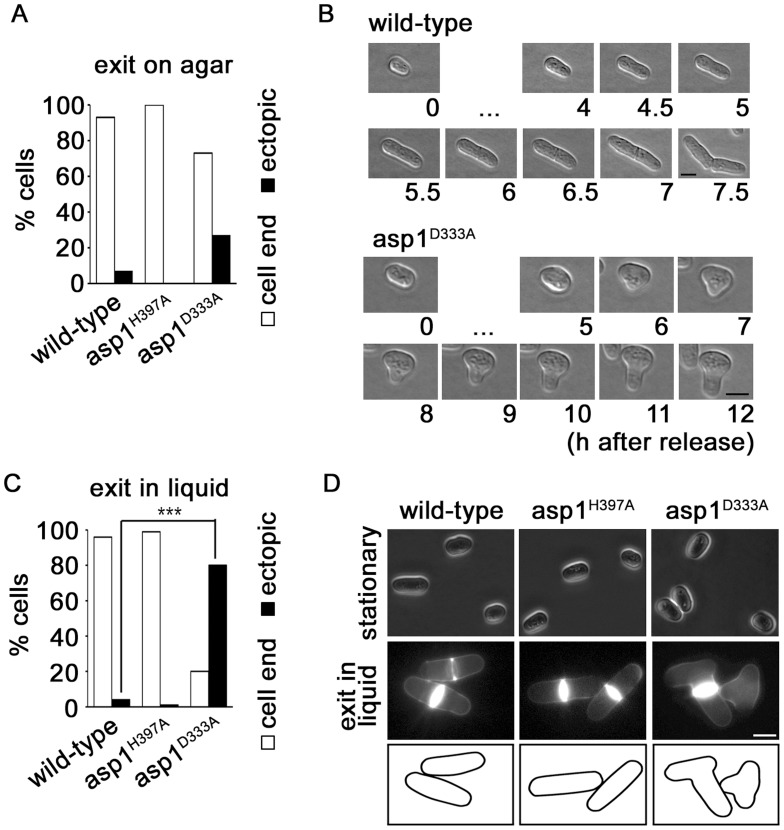
Asp1 is required for growth zone selection.(A) The indicated strains were released from stationary phase by streaking cells on solid YE5S at 25°C and analyzing the cell shape microscopically. Wild-type strain, n = 16; asp1H397A, n = 19; asp1D333A strain, n = 15. (B) Photomicrograph of a wild-type and asp1D333A cell that exits stationary phase on solid agar. Bars, 5 µm. […] denotes no change in cell morphology at these time points. (C) The indicated strains were released from stationary phase by inoculating an aliquot with YE5S liquid medium. Phenotype was scored after 7 hrs at 25°C. Wild-type strain, n = 142; asp1H397A, n = 110; asp1D333A strain, n = 122 ***p<0.001 asp1D333A compared to wild-type as determined using χ2-test. (D) Photomicrographs of cells in stationary phase (top panels) and after release into YE5S liquid medium (bottom panels). Cells were stained with Calcofluor white. Bar, 5 m.